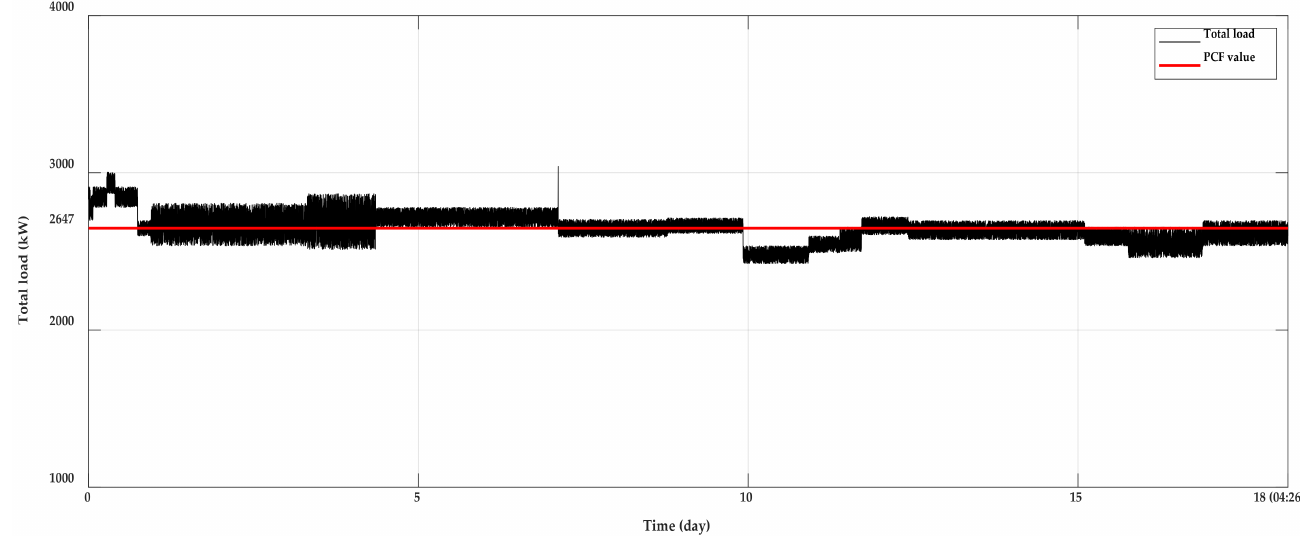
Figure 6. Total load graph excluding the low total load data.